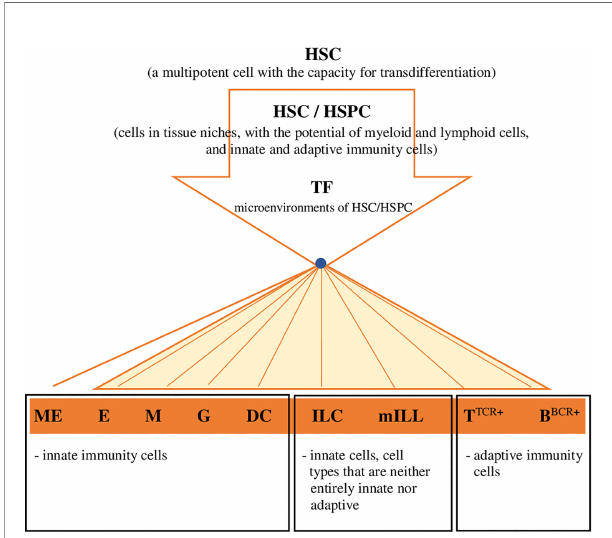
FIGURE 2 | Hypothetical model for the development and differentiation of HSCs, in multiple directions speci fi c for lineages, continuous and without creating a distinct hierarchy of organized progenitor populations (proposed by the authors). Explanatory noted: HSC, haematopoietic stem cell; HSC/HSPC, haematopoietic stem cell/hematopoietic progenitor cell (migratory/tissue, resident); TF, transcription factor (or sequence,speci fi c DNA,binding factor) in the environment of HSC-HSPC cells; ME, megakaryocytes/source of platelets in mammals/thrombocytes in fi sh; E, erthcrocytes; M, monocytes/ macrophages; G, granulocytes; DC, dendritic cells; ILC (ILC1; ILC2; ILC3/ NK; LTi), innate lymphoid cells; mILL (T gd lymohocytes [IEL, intraepithelial lymphocytes]; mucosal associated invariant T cells [MAIT]; NKT cells; B1 lymphocytes [unconventional BCD5+ lymphocytes]; marginal zone B cells), mammalian unconventional or innate-like lymphocytes; TTCR+, TTCR+ lymphocytes and their subpopulations; BBCR+, B BCR+ lymphocytes and their